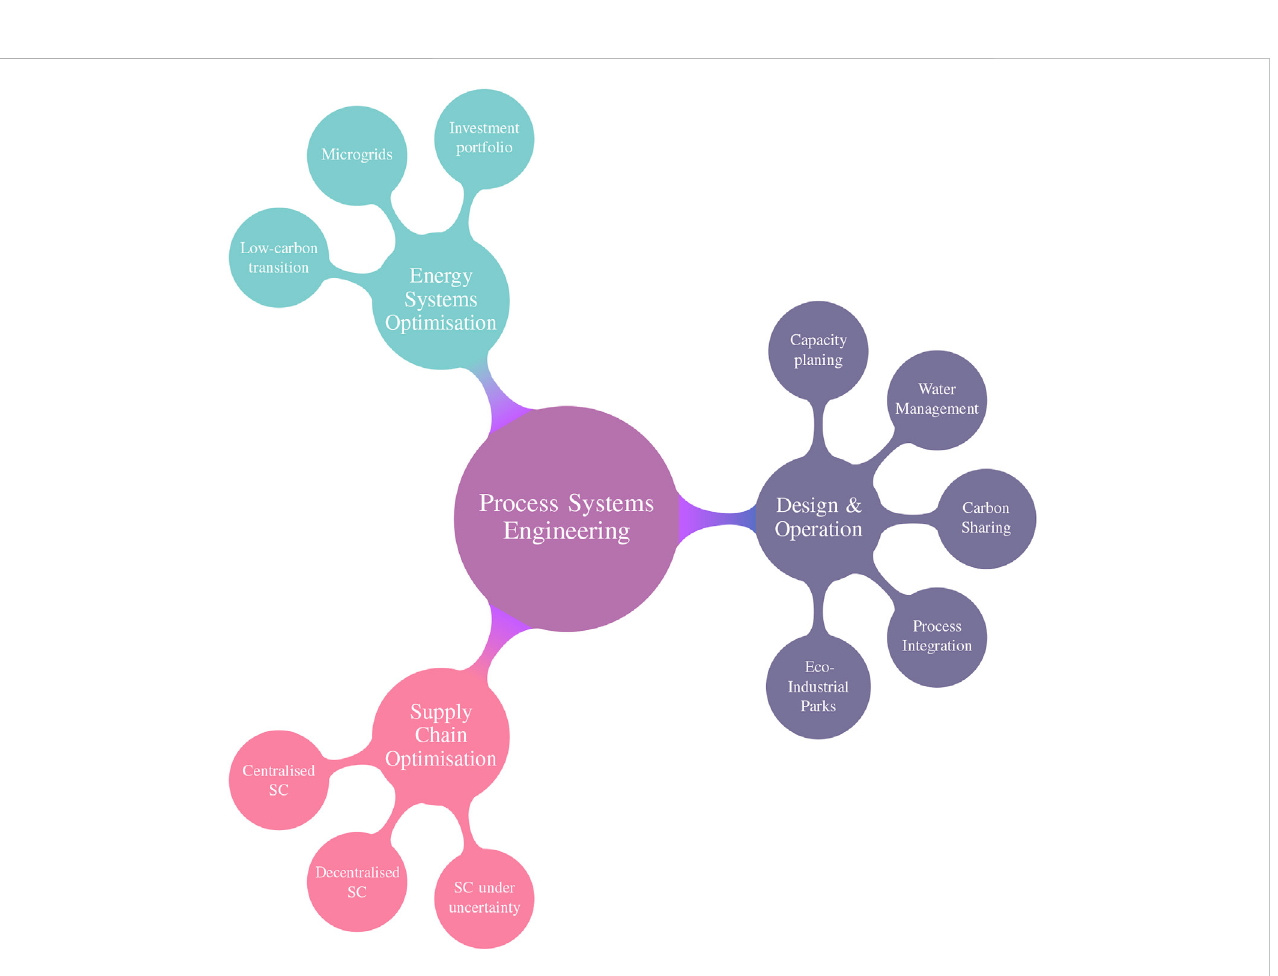
FIGURE 2 Graphic illustration of game theoretic applications in